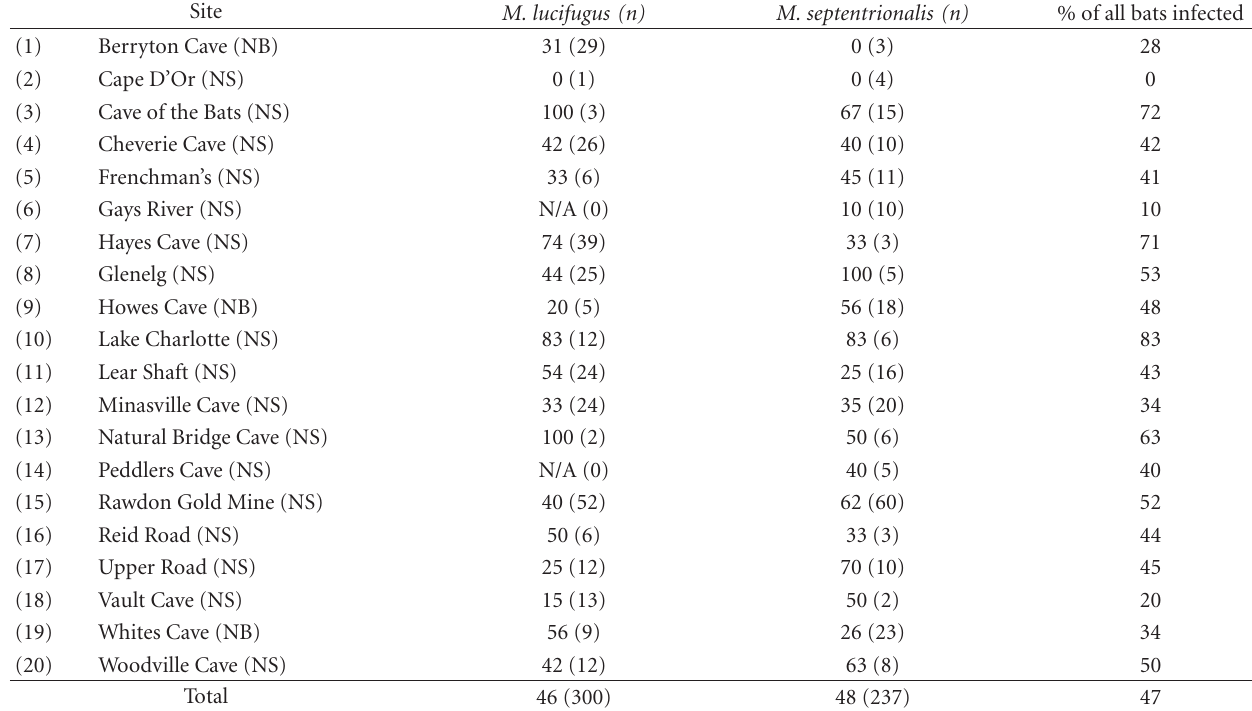
Table 2: Prevalence (%) of infection (sample size) of Myotis lucifugus and M. septentrionalis with any ectoparasite at each of 20 swarming sites in Nova Scotia and New Brunswick, Aug–Oct